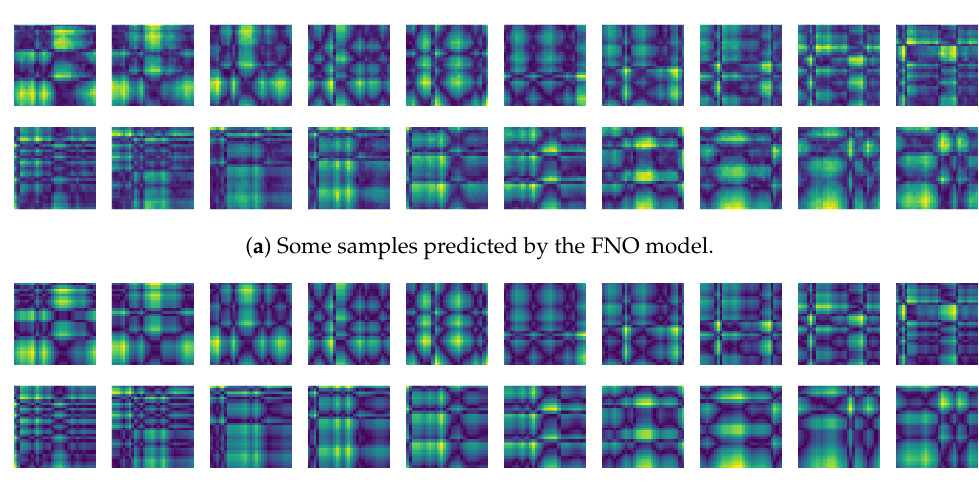
( b ) The target cross recurrence plot to be predicted from the FNO model (a) and CNN model (c).